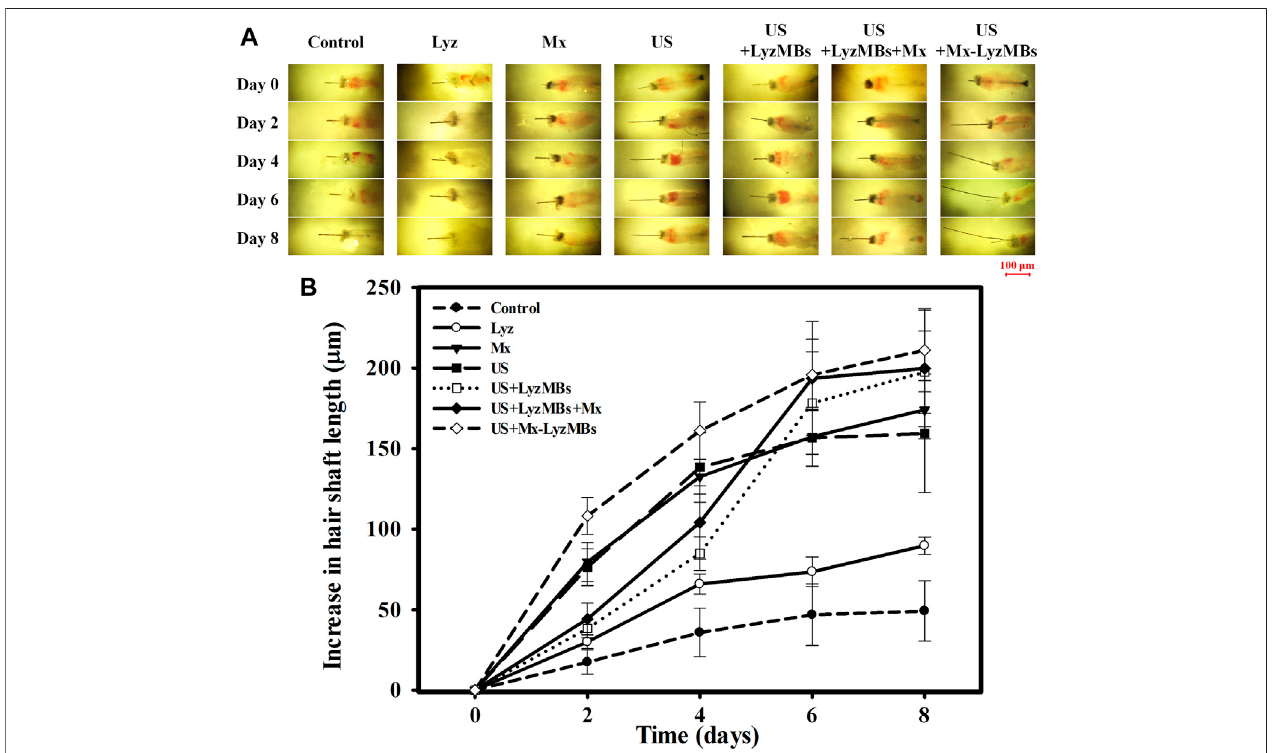
FIGURE 7 | (A) Representative photographs of vibrissae cultured with or without treatments in an in vitro vibrissae culture system. (B) Growth curves for the vibrissae shafts over time in the seven treatment groups. Data are mean and SEM values.